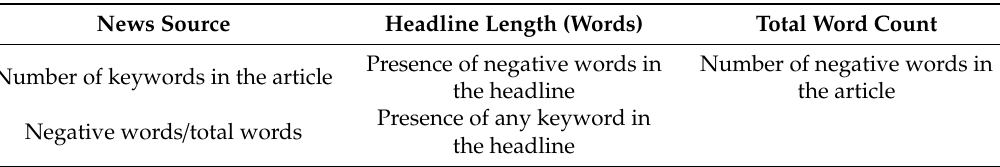
Table 4. The features of news articles used in this study.